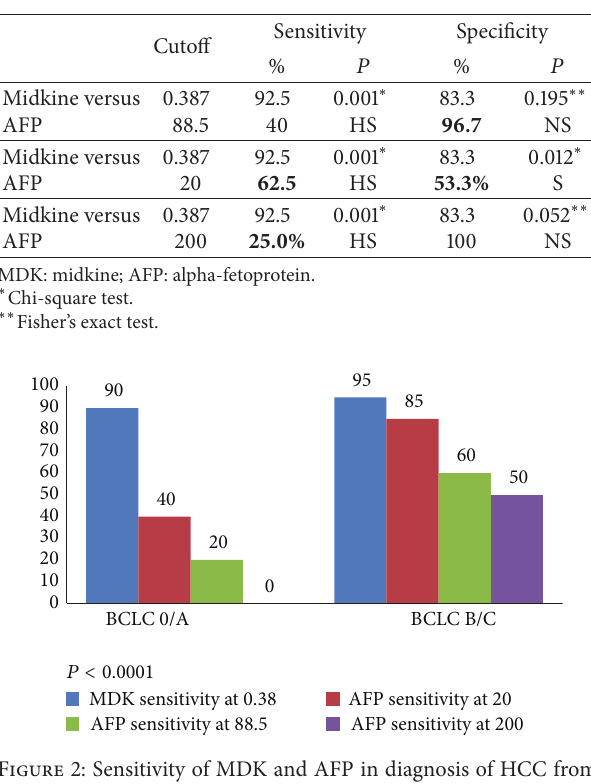
Table 3: Comparison between MDK at cutoff value 0.387 ng/mL and AFP at cutoff values 88.5, 20, and 200 ng/mL regarding sensi- tivity and specificity in diagnosis of HCC.